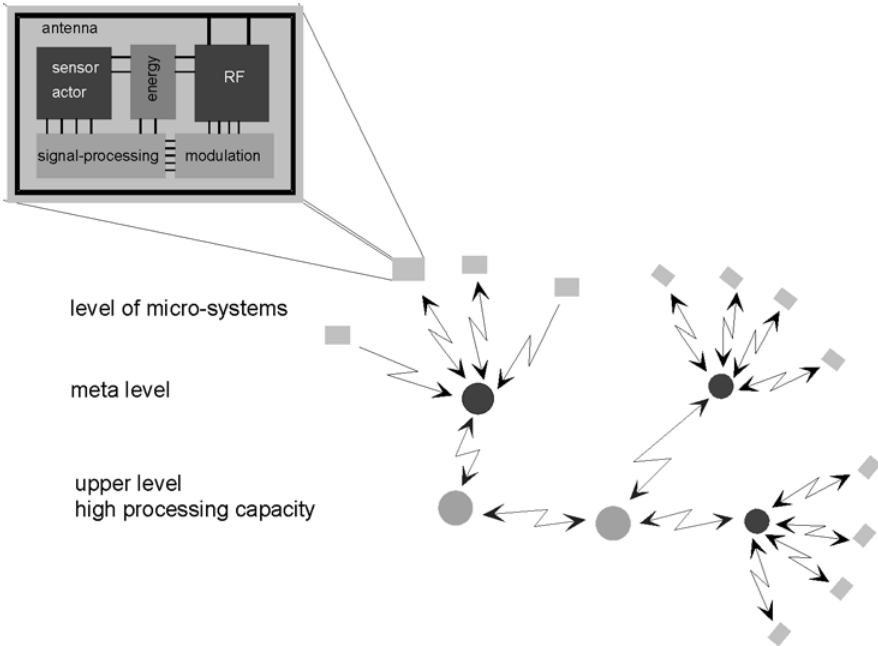
FIGURE 2 Principal topology of a micro-systems network.